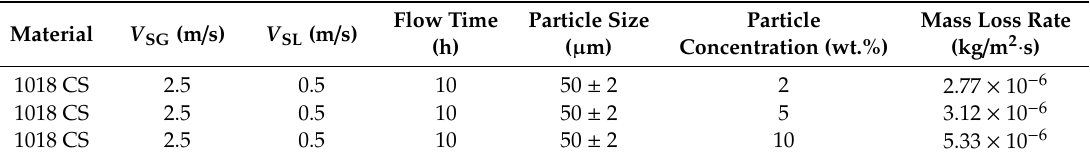
Table 4. Loss rates of tested 90 ◦ elbows for slug flow.